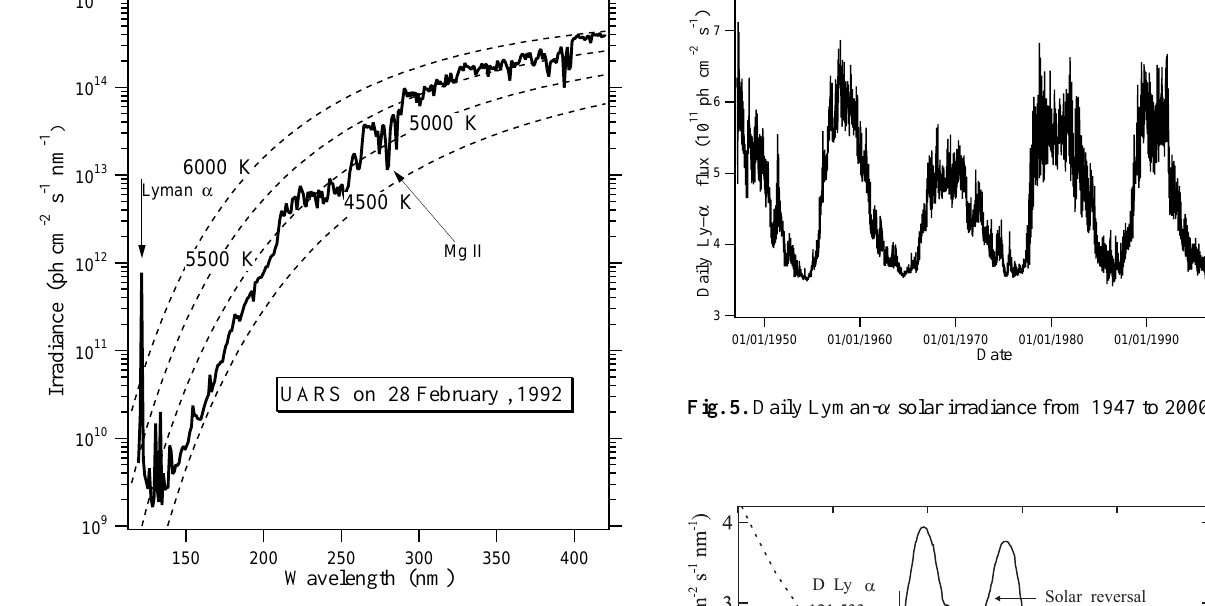
Fig. 4. Solar irradiance as a function of wavelength.